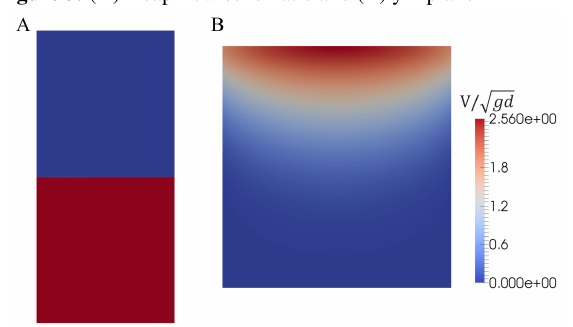
Figure 4. (A) Granular (red) and air (blue) layers and (B) gran- ular layer flow field in the y − z